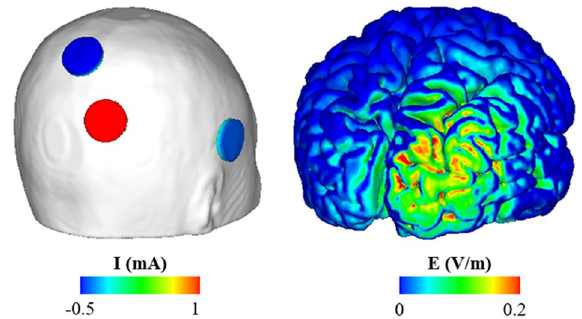
Figure 5. The final montage and electric field distribution. (From left to right) the three-channel electrode montage and optimal injection current amplitude used in this study and electric field distribution under the determined electrode condition.